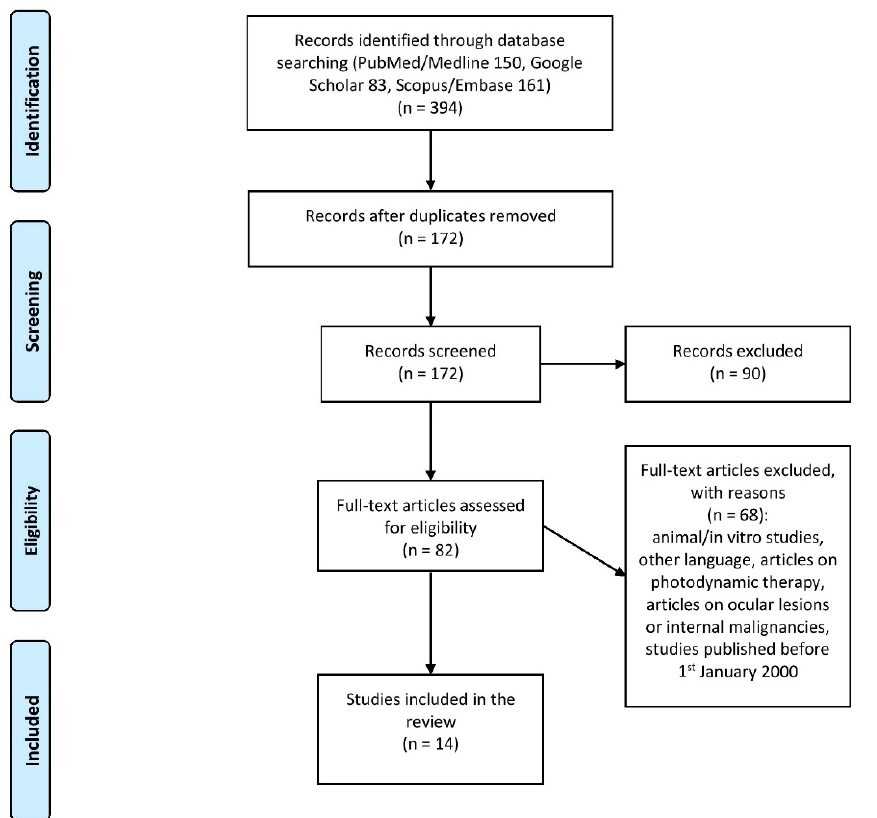
Figure 1. PRISMA flow chart for study